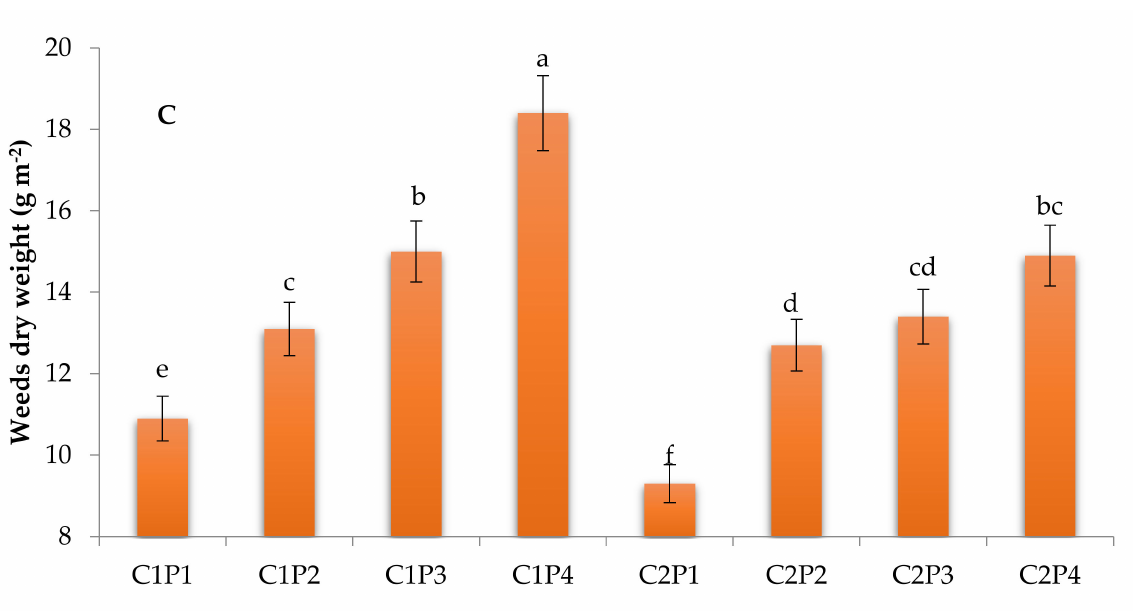
Figure 3. Weed infestation as indicated by ( A ) the density of weeds, ( B ) fresh weight of weeds and ( C ) dry weight as influenced by the genetic divergence of cowpea cultivars and row configuration under a temperate climate. C 1 = cowpea cultivar Cowpea − 2007, C 2 = cowpea cultivar Rawan − 2010, P 1 = R × R of 15 cm, P 2 = R × R of 30 cm, P 3 = R × R of 45 cm, P 4 = R × R of 60 cm. Column bars having different letters significantly vary at p =